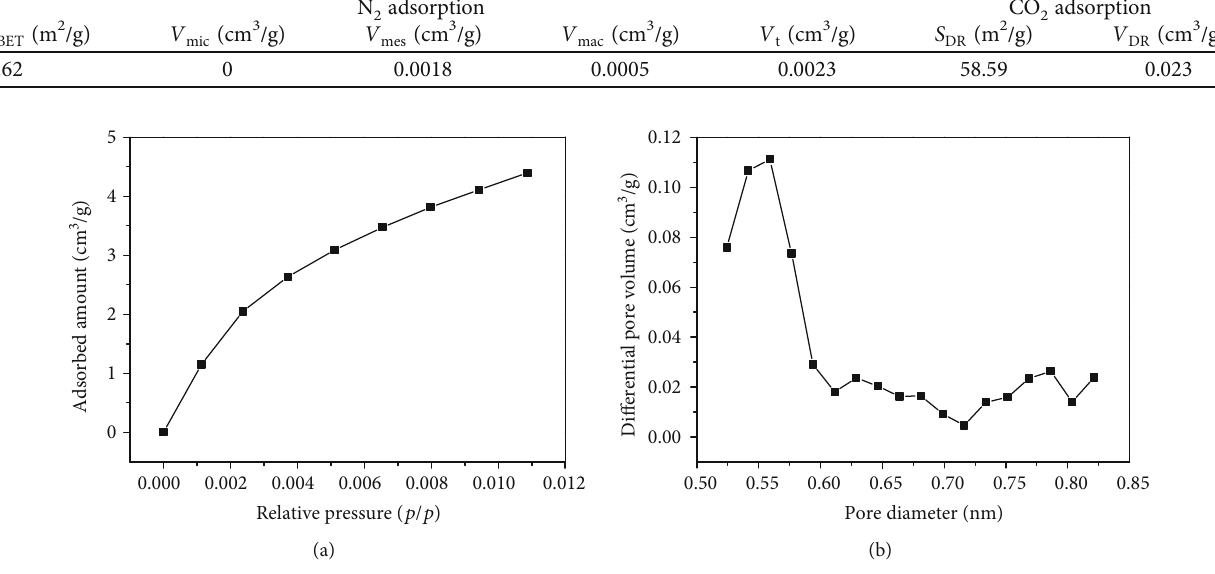
Figure 2: CO adsorption isotherm at 273.15K (a) and micropore size distribution 2